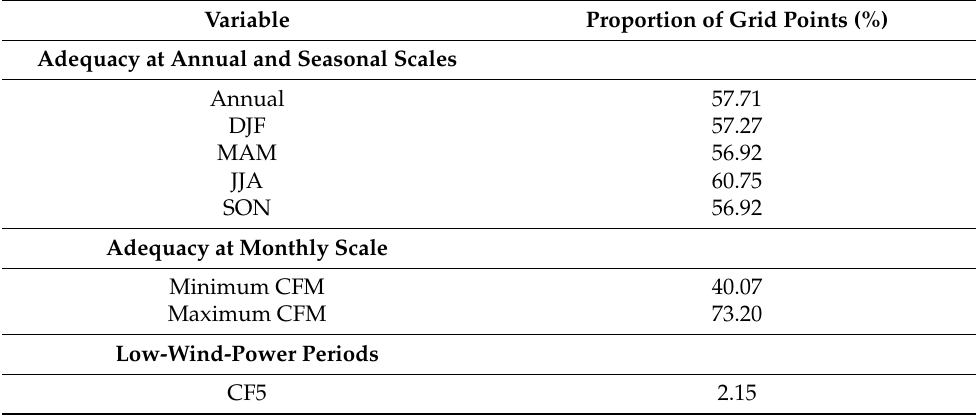
Table 2. The percentage of grid points exhibit adequate wind power potential (CF ≥ 0.2) at different time scales (annual, seasonal, and monthly) on average, and in low-wind-power periods.